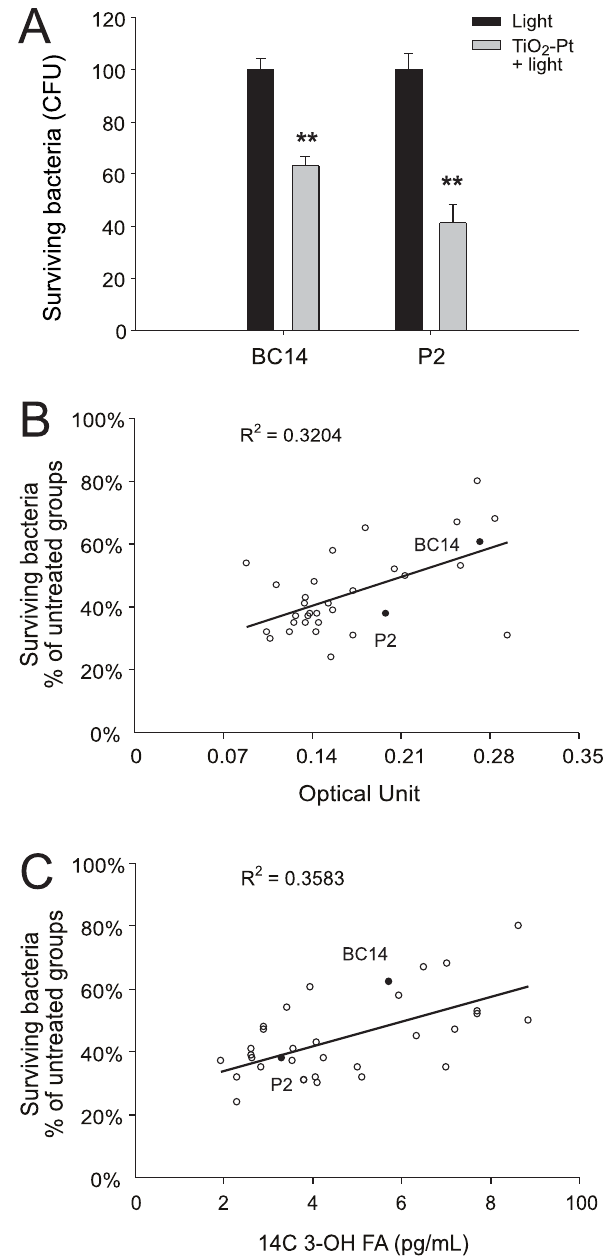
Figure 5. Association between biofilm formation and resis- tance to photocatalysis. The survival rate of B. cenocepacia cells (strains BC14 and P2) in biofilms after the photocatalysis treatments is shown (A). The data are presented as mean 6 SD. Correlations between the bacterial survival rates of 30 different B. cenocepacia isolates and their ability to form biofilms are indicated; optical unit: the residual crystal violet in the biofilm, which represents relative biofilm mass (B). The correlations between the bacterial survival rates and the medium lipopolysaccharide (LPS) levels are indicated; [C14:0 3-OH FA]: an indicator of LPS, which represents relative LPS levels (C). n=6, three experiments with 2 replicates.